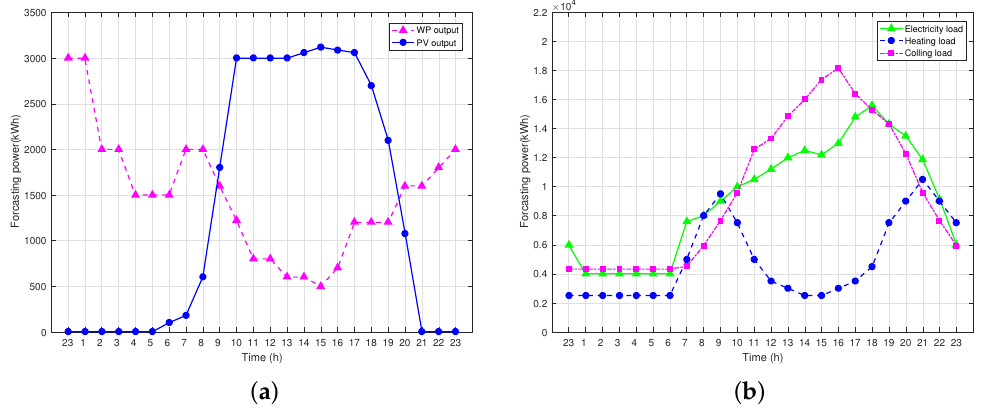
Figure 6. The load forecast of demands and new energy power generation for the IES in Xi’an in China on 15 August 2020. The capacity of devices and energy supply methods of IES are shown in Table 1 and Figure 1. ( a ) the forecast output of wind power and photovoltaic power; ( b ) the load forecast of the